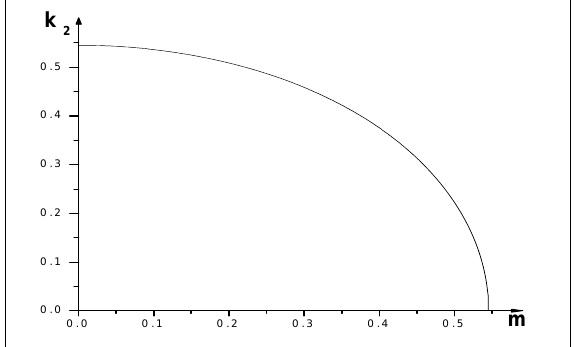
Figure 4. The rationship curve graph of